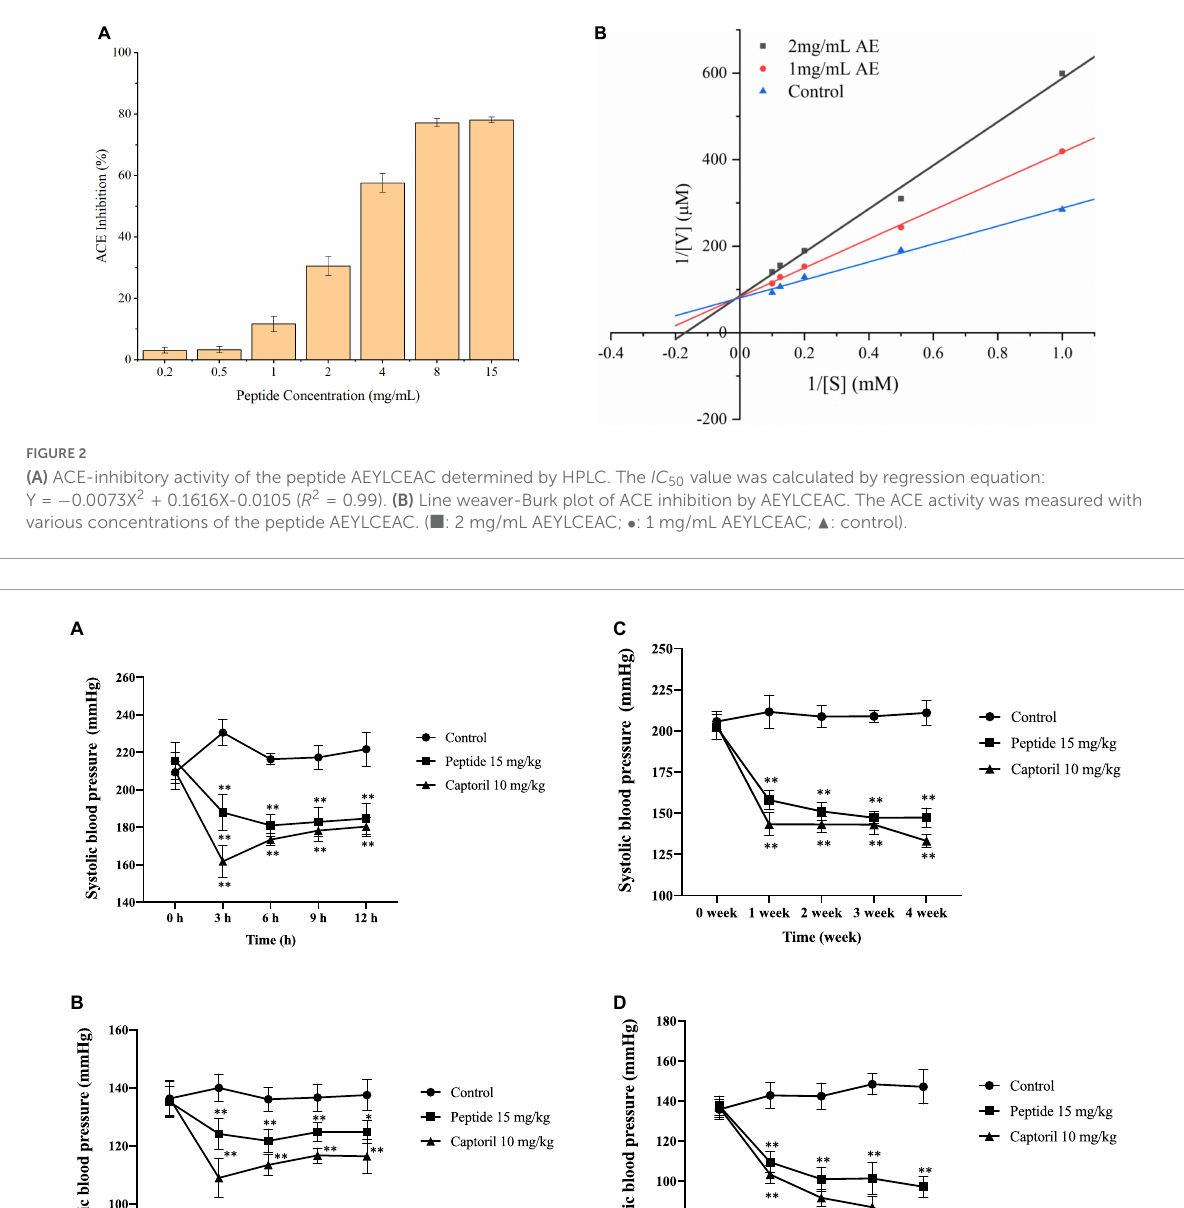
the peptide group and positive group after the administration from 3 to 12 h ( ** p < 0.01). And both SBP and DBP is lowest in at 3 h, then increased slightly. Compared with the peptide group, DBP in the peptide group was significantly decreased ( ∗∗ p < 0.01). In Figure 3B , in a 4-week of animal